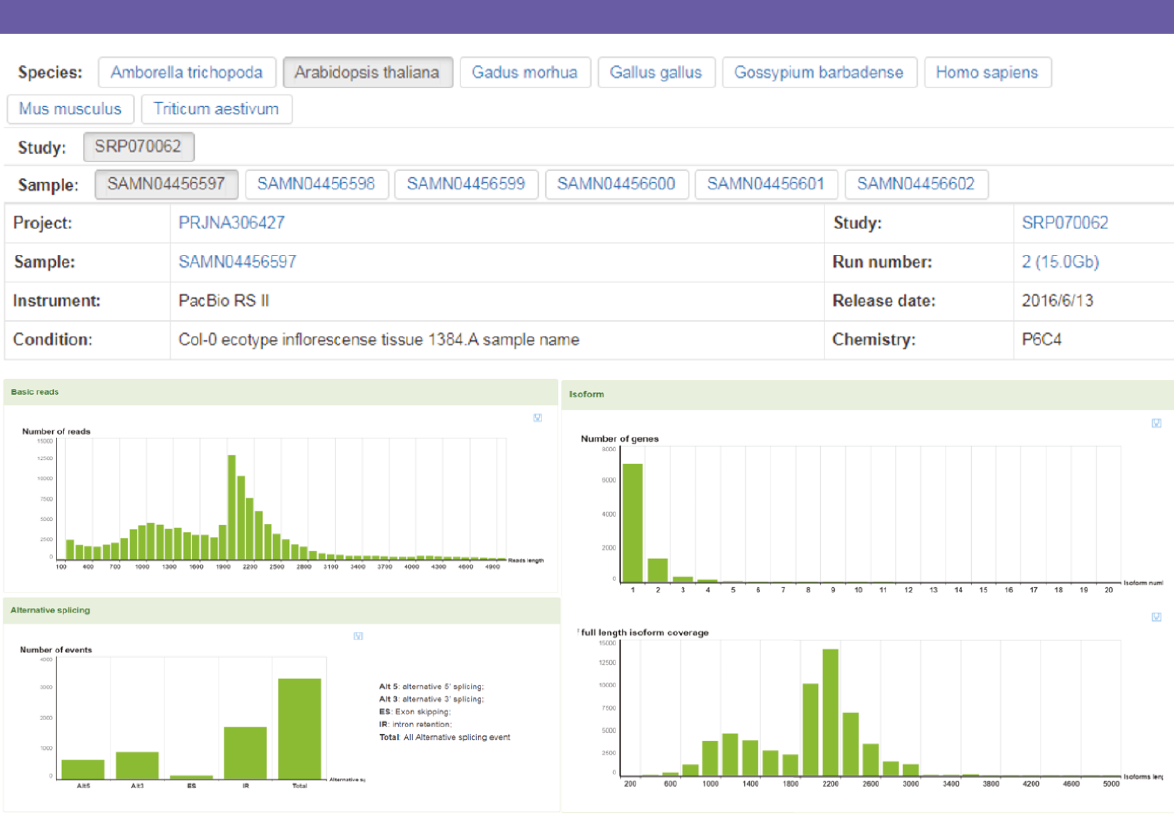
Figure 4: The sample browse results from